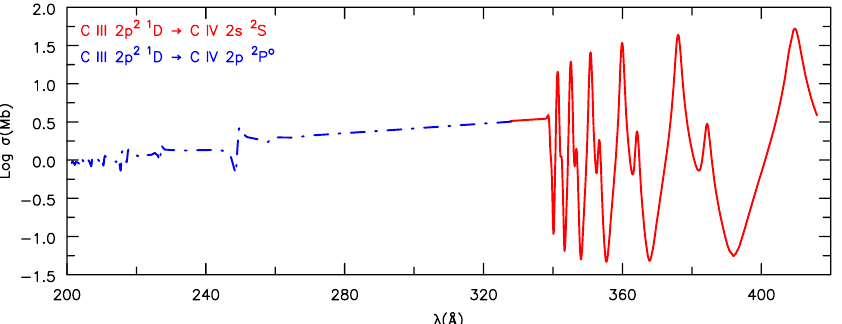
Figure 2. Illustration of the photoionization cross-section (in megabarn, with 1Mb = 10 − 18 cm 2 ) of C III 2p 2 1 D. Ionization to the C IV ground state occurs via autoionizing levels such as C III 2p 4d 1 F o . Shortward of ≈ 325Å, photons have sufficient energy to ionize directly to C IV 2p 2 P o . The data were convolved with a Gaussian profile with a full width at half maximum of ∼ 600kms − 1 (i.e., σ = 250.0kms − 1 ). The photoionization cross-sections for C III were computed by P. J. Storey (private communication). In other photoionization cross-sections the resonances are often much narrower than those shown